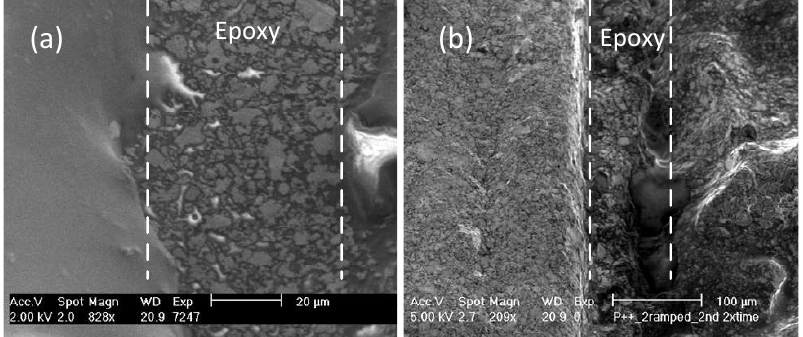
Figure 7. SEM image of the CW2400 epoxy at the interface of the PZT element and the stainless-steel layer with ( a ) and without ( b ) the mixture of 353ND epoxy.